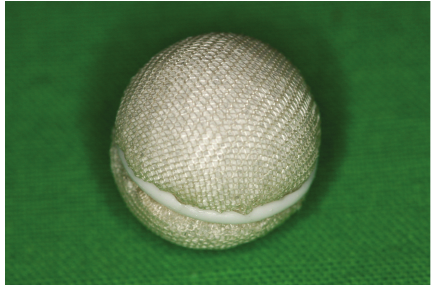
Figure 2: HA orbital implant with the polyglactin 910 mesh cover- ing at the time of